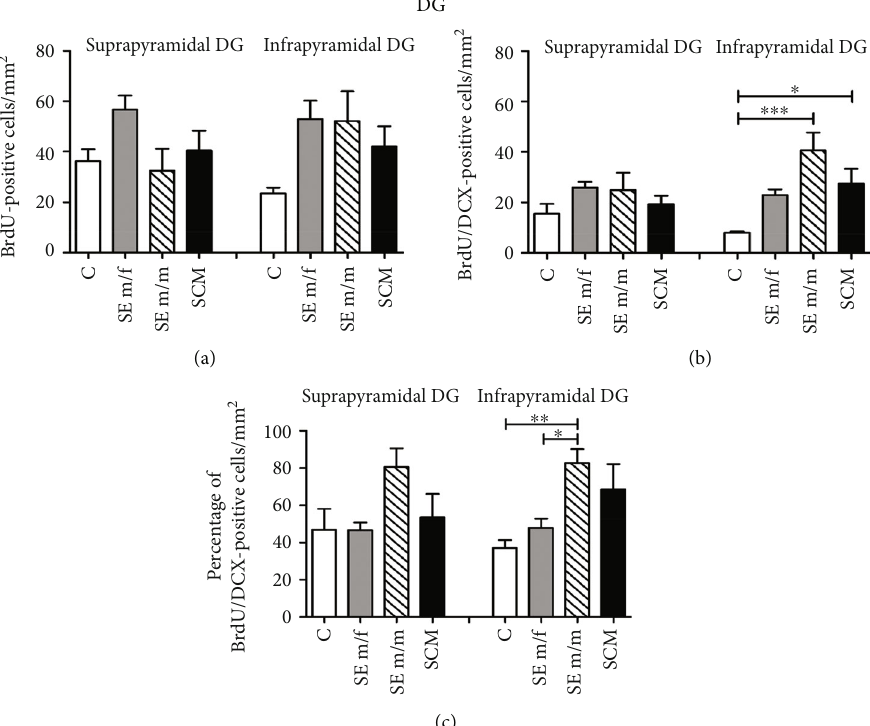
Figure 8: Cell proliferation, total BrdU/DCX-positive cells, and percentage of BrdU/DCX-positive cells (a – c) for the control (C), social exposure to a female (SE m/f), social exposure to a male (SE m/m), and social cohabitation with mating (SCM) male voles. Data were analyzed by one-way ANOVA followed by Bonferroni ’ s post hoc test. ∗ p < 0 : 05 , ∗∗∗ p < 0 : 001 . Results of ANOVA analyses are provided in the text. Suprapyramidal blade of the DG: C ( n = 7 ), SE m/f ( n = 7 ), SE m/m ( n = 6 ), and SCM ( n = 5 ); infrapyramidal blade of the DG: C ( n = 5 ), SE m/f ( n = 6 ), SE m/m ( n = 5 ), and SCM ( n = 5